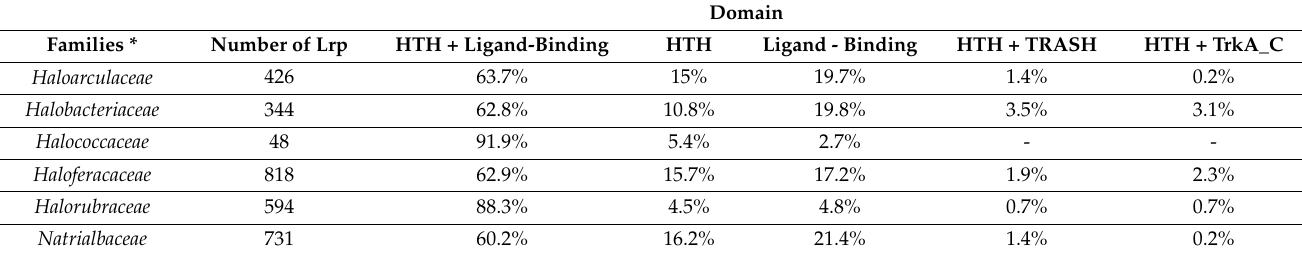
Table 2. Proteins annotated as Lrp/AsnC in halophilic archaeal families and their protein domain structures.